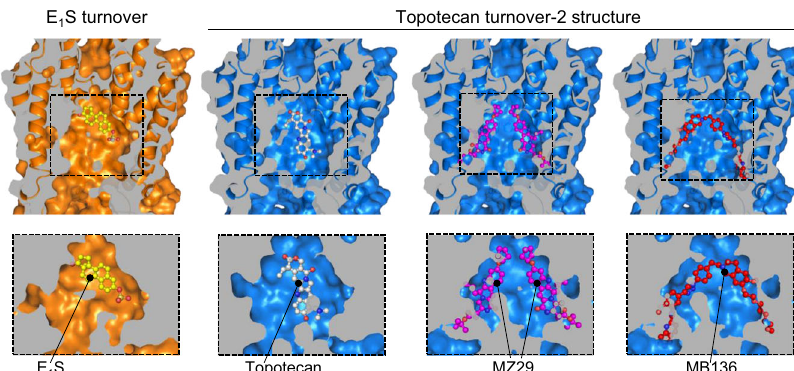
Fig. 5 Cavity 1 in turnover-2 state accommodates substrates but not inhibitors. Vertically sliced views through E 1 S-bound (left) and topotecan-bound (right) turnover-2 structures. The top row of panels shows the TMDs both as ribbons and in surface representation. The bottom row shows close-up views of cavity 1, with ABCG2 in surface representation. Bound E 1 S and topotecan are shown in mixed stick/sphere representation as built in the structures. Inhibitor structures were extracted from inward-open ABCG2 structures containing these inhibitors (PDB 6ETI and 6FEQ, respectively). To place inhibitors into cavity 1 of the turnover-2 state, we aligned the phenyl moieties of the two F439 residues in PDB 6ETI or in 6FEQ with those of our turnover structures. In this way the translocation pathway of PDB 6ETI, 6FEQ, and turnover-2 are well-aligned and inhibitors can be fi t. The inhibitors placed into cavity 1 of the topotecan turnover-2 emphasize the resulting steric clashes.